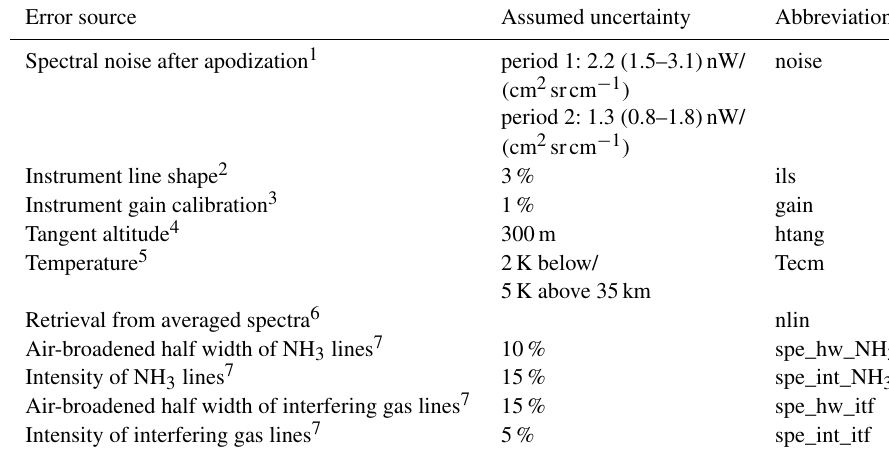
Table 1. Assumptions on uncertainties used for the error assessment in Fig.